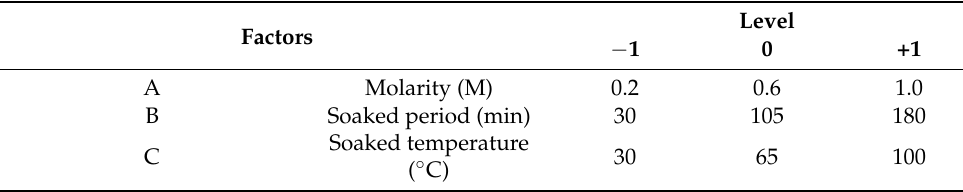
Table 2. Process factors and factor levels of the adsorbent preparation